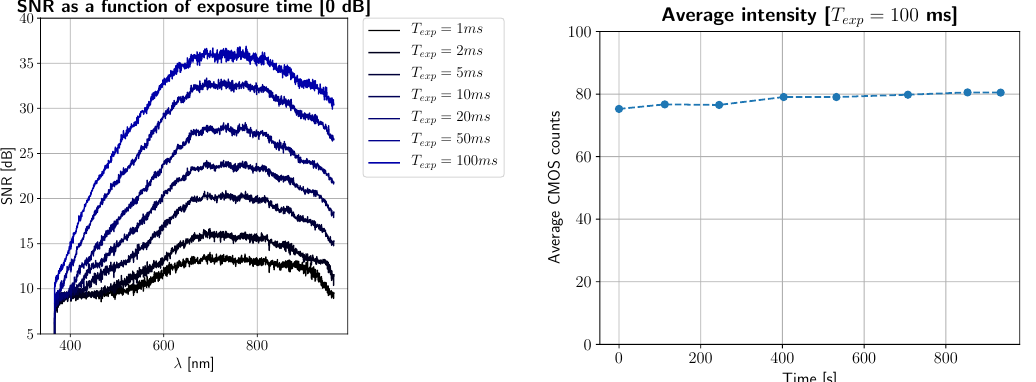
Figure 12. Left: Signal-to-noise ratio (SNR) of reflectance as a function of exposure time and wavelength. Right: Light source stability during the first 800 s of